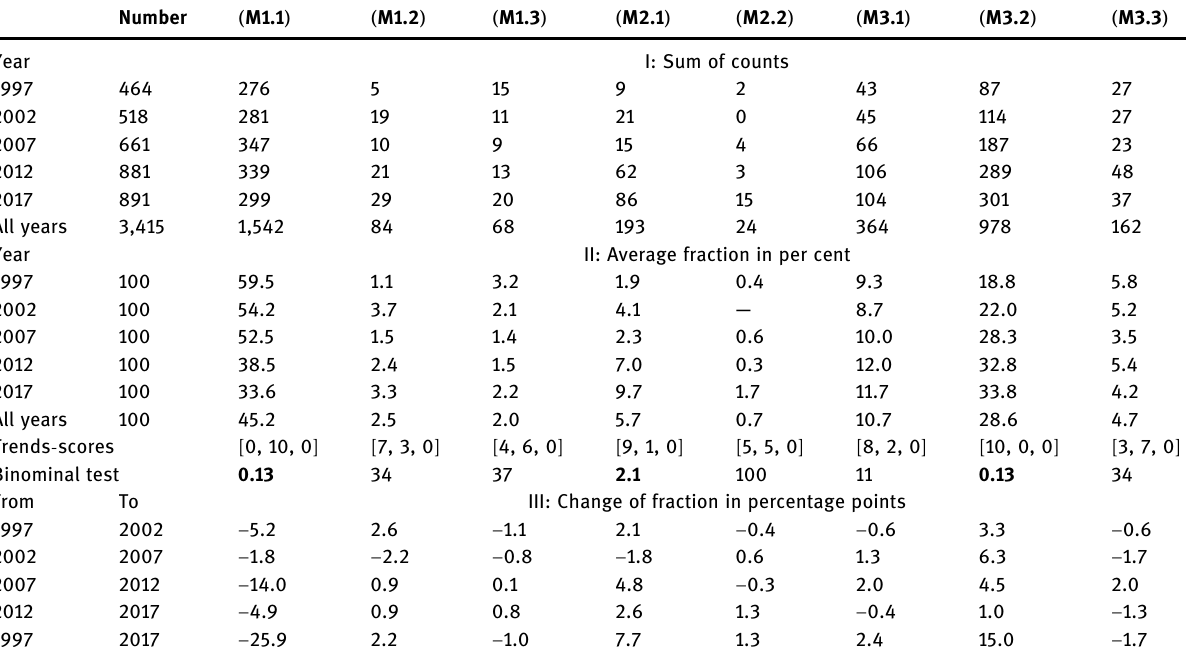
Table A2: Counts, shares, and changes for all ten journals for subgroups Number ( M1.1